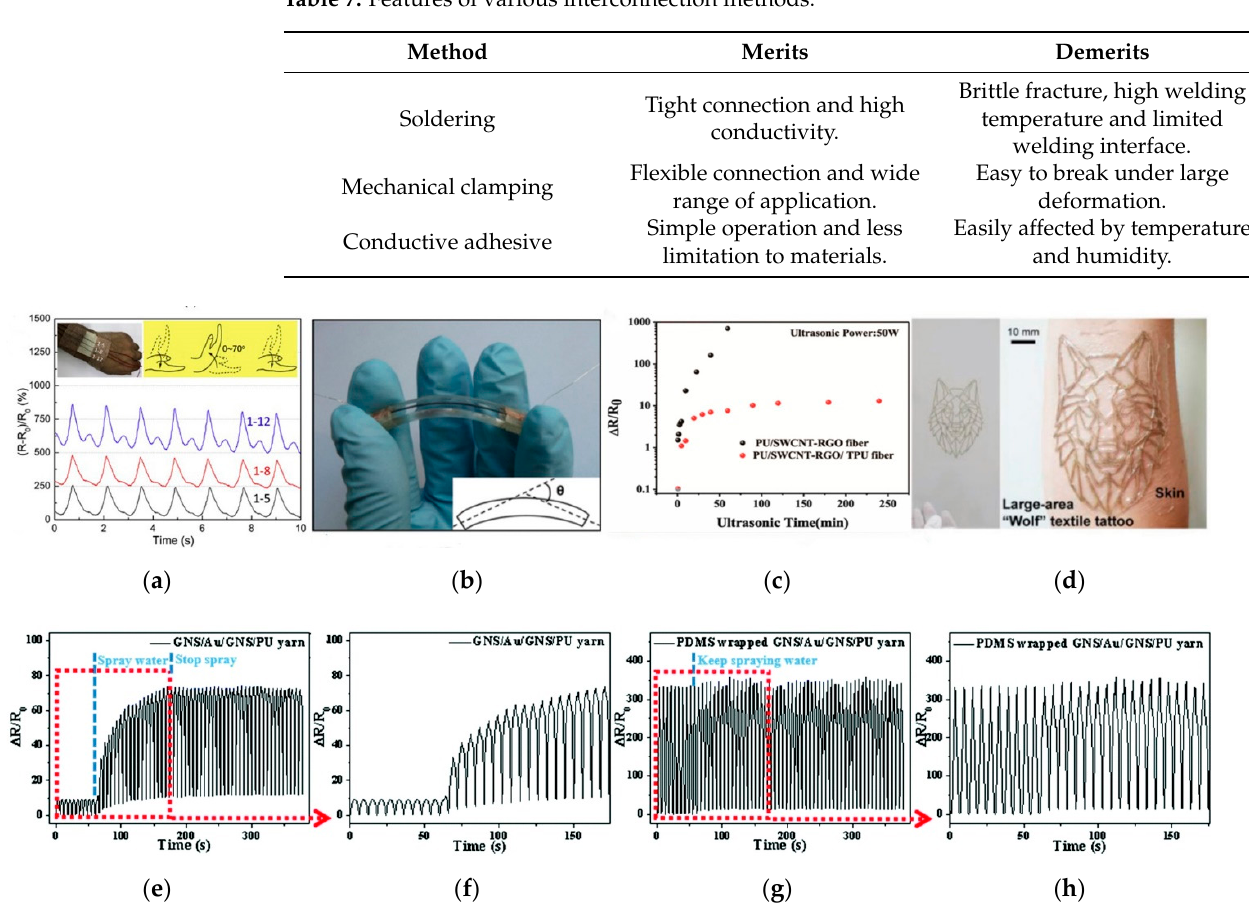
Table 7. Features of various interconnection methods.